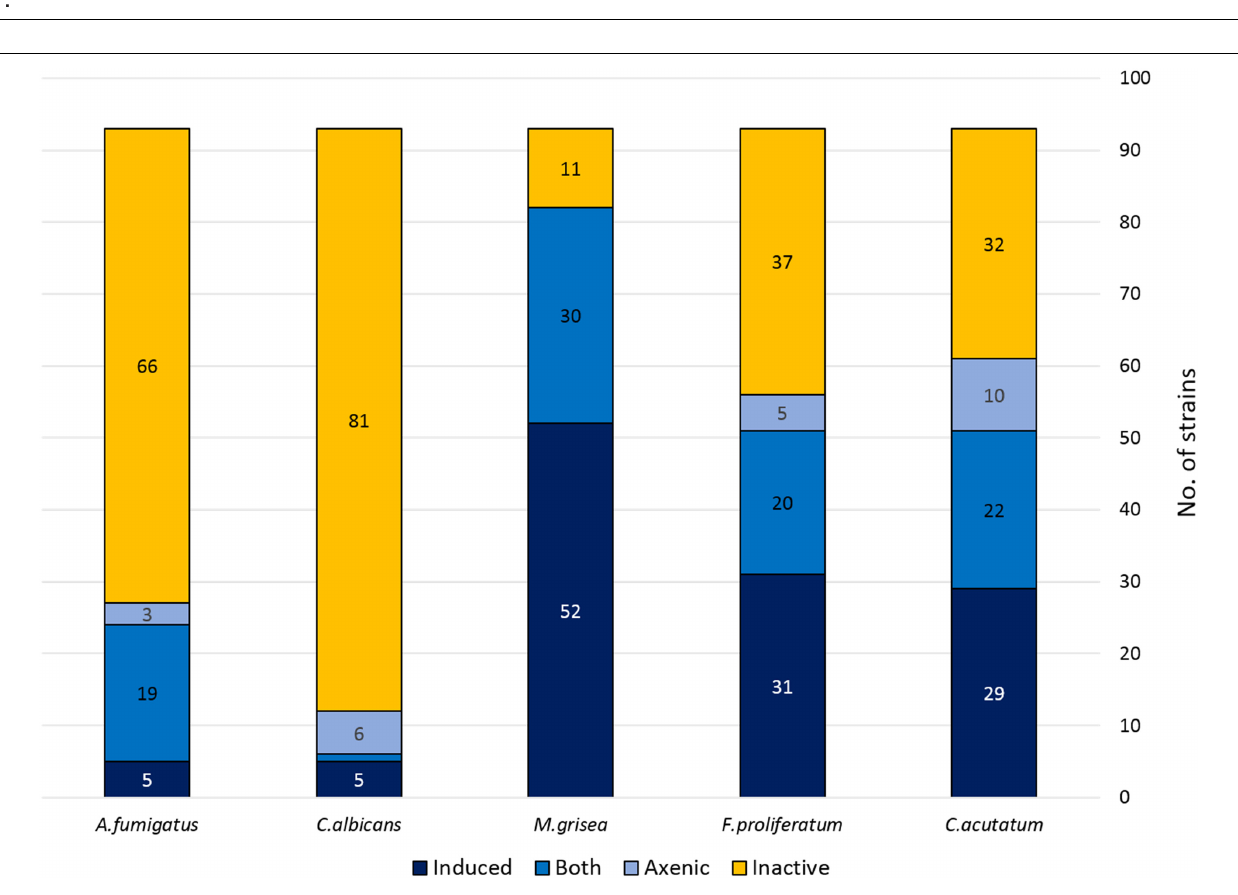
FIGURE 3 | Antifungal activity distribution of the co-culture